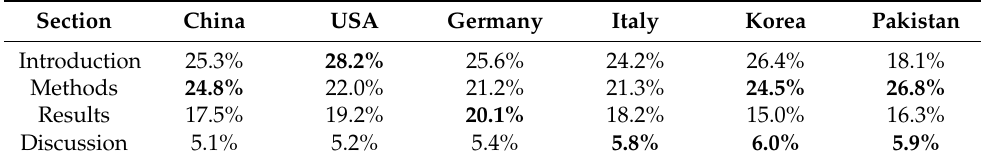
Figure 10. Average numbers of words ( left ) and average numbers of equations ( right ) for selected countries of first affiliations of articles published in Remote Sensing . Table 7. Average fraction of words per article section of selected